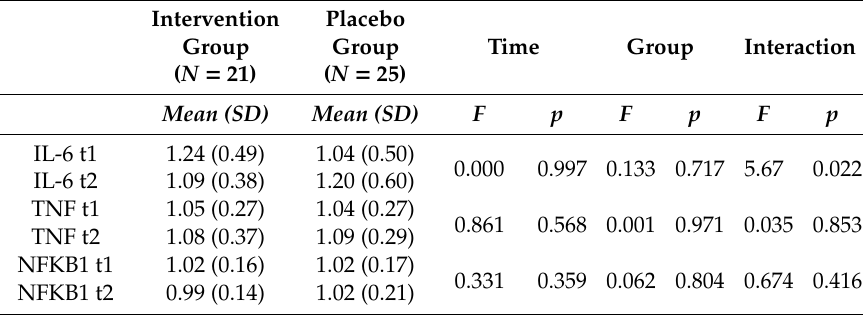
Table 4. Results in IL-6 gene expression after four weeks of probiotic